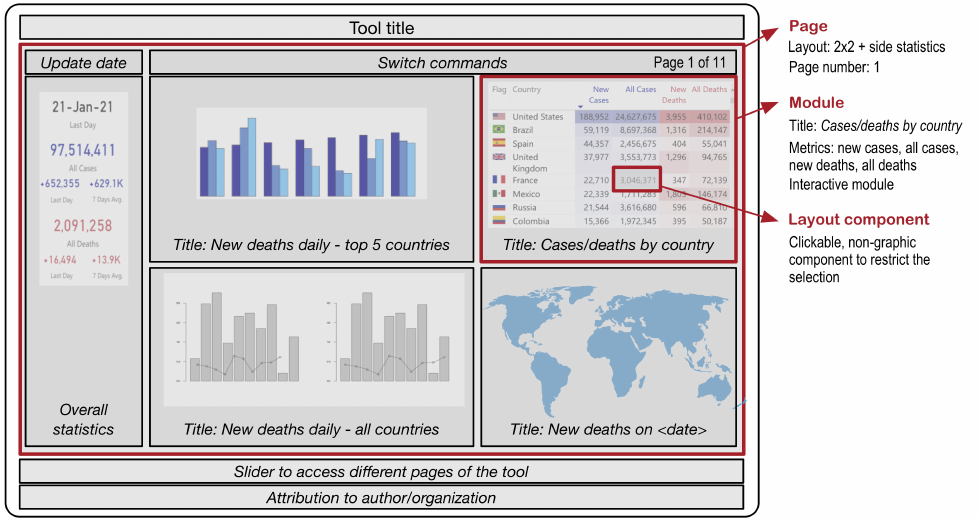
Figure 6. Possible structure of an interactive Geo-OEDV tool, inspired to the “Dashboard|COVID-19” by Andrzej Leszkiewicz; available online: https://avatorl.org/covid-19/; screenshot date: 23 January